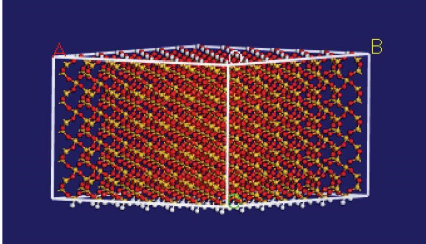
Figure 5: Hydrated silica model (hydrogen is white).